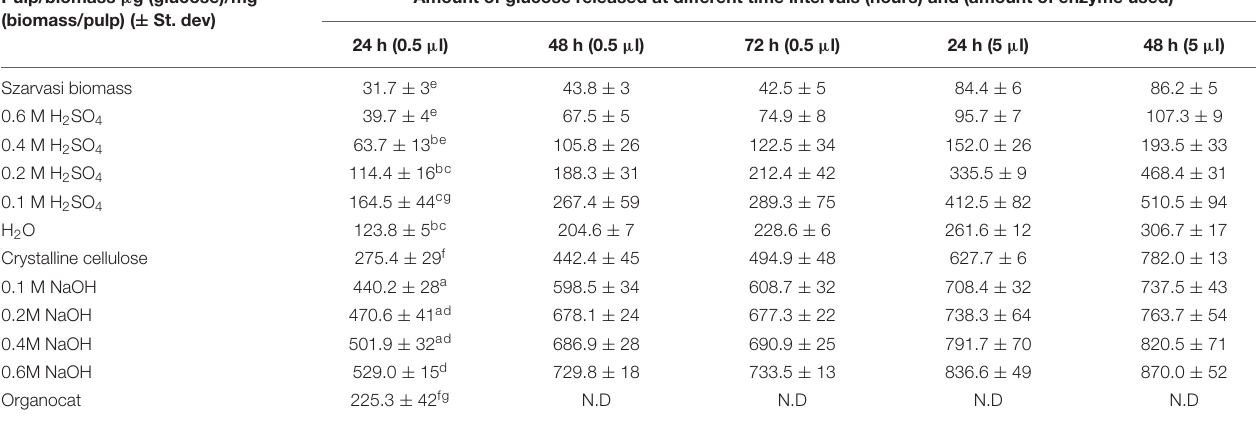
TABLE 2 | Release of glucose [ µ g glucose/mg (biomass/pulp)] by enzymatic hydrolysis at different incubation times and enzyme concentrations of Szarvasi materials (biomass, remaining pulps after microwave pretreatment with various concentrations of acidic or alkali catalyst). Pulp/biomass µ g (glucose)/mg Amount of glucose released at different time intervals (hours) and (amount of enzyme used) (biomass/pulp) ( ± St. dev)